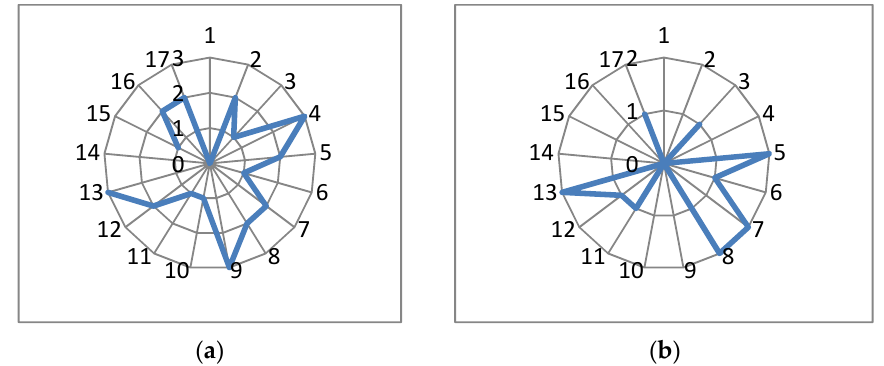
Figure 4. ( a ) Poland’s level of achievement; ( b ) Poland’s companies’ coverage of the SDGs (incident rate in COPs).